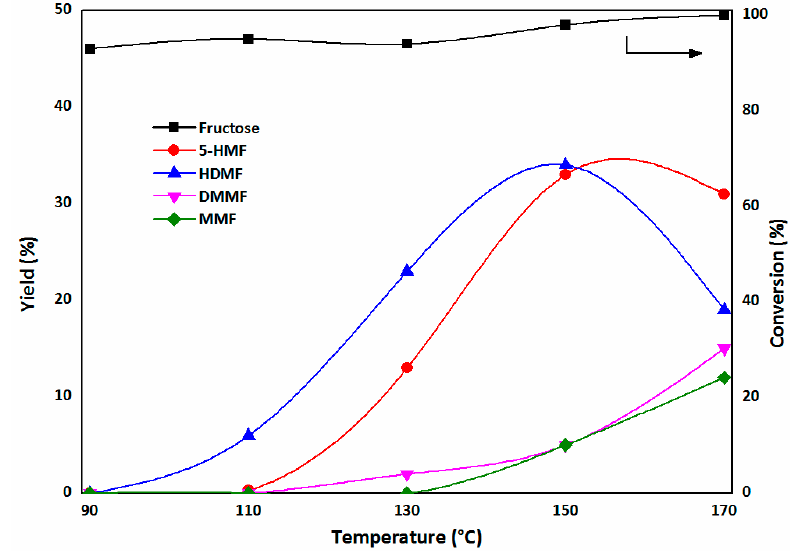
Figure 3. Effect of temperature on the reaction. Reaction conditions: 30 min, 1.37 mmol fructose, 50 mg SiO 2 ‐ HNO 3 , 4.0 mL solvent (DMSO/methanol 30/70 v / v ). SiO 2 -HNO 3 , 4.0 mL solvent (DMSO/methanol 30/70 v / v